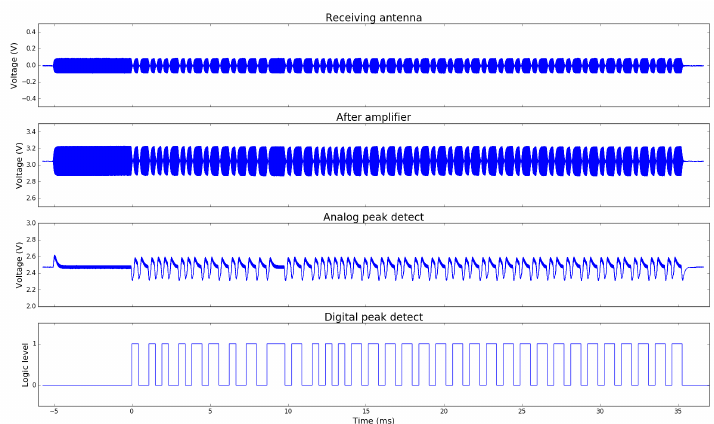
Figure 9: The first (top) plot shows the analog signal received by the antenna (measured at TP2). The second plot shows the analog signal after passing through the Proxmark’s LORAW receive path (measured at C41). The third plot shows the result of the Proxmark’s analog peak detect circuit (measured at TP1), this analog signal is digitized by an 8-bit ADC, the output of which is processed by the FPGA to produce the final digital peak detect signal (measured at TP7). This signal is processed by the microcontroller and results in the demodulated